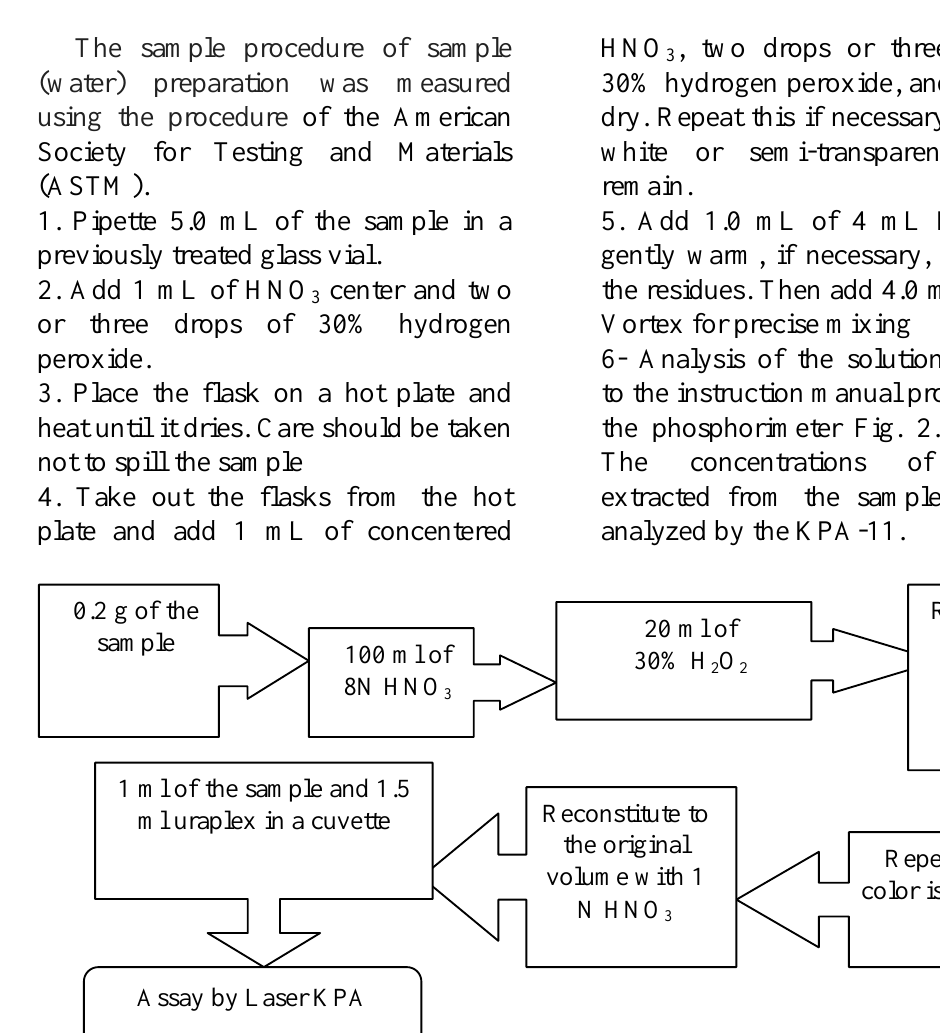
Repeat if the color is not clean